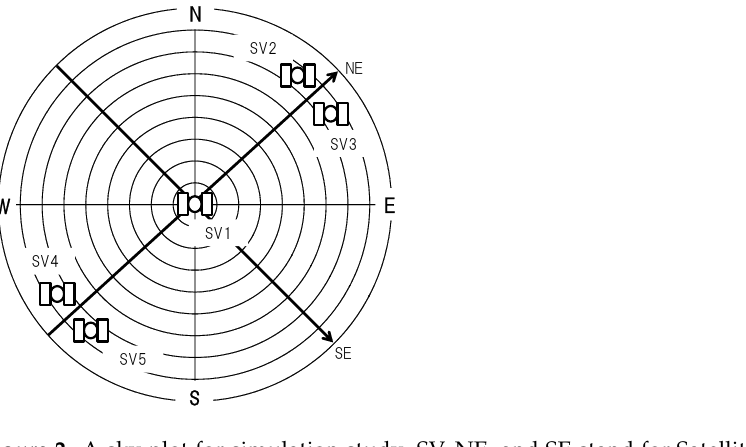
Figure 2. A sky plot for simulation study. SV, NE, and SE stand for Satellite Vehicle, a northeast direction, and a southeast direction